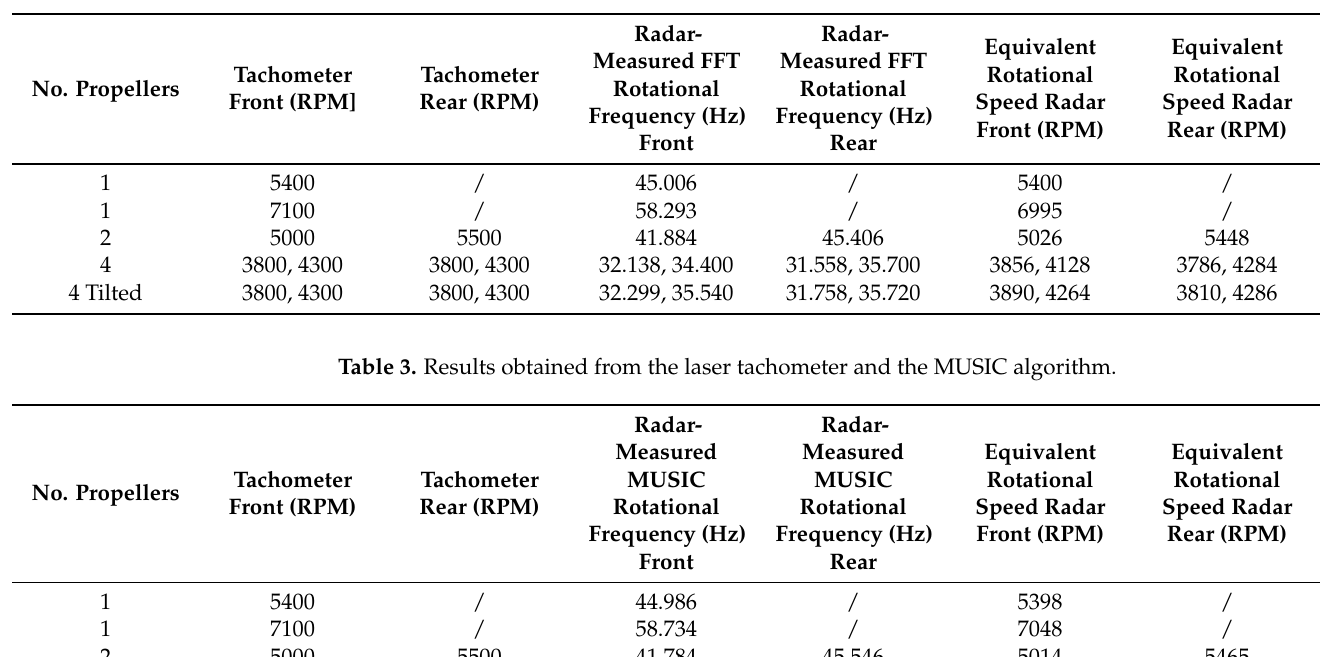
Table 2. Results obtained from the laser tachometer and the FFT technique.